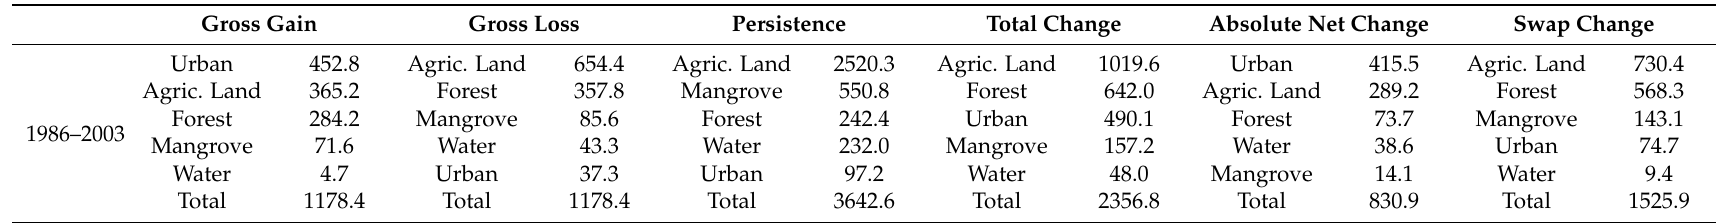
Table 8. Ranking of gross gains, gross losses, persistence, total change, and swap change of LULC categories between 1986–2003.